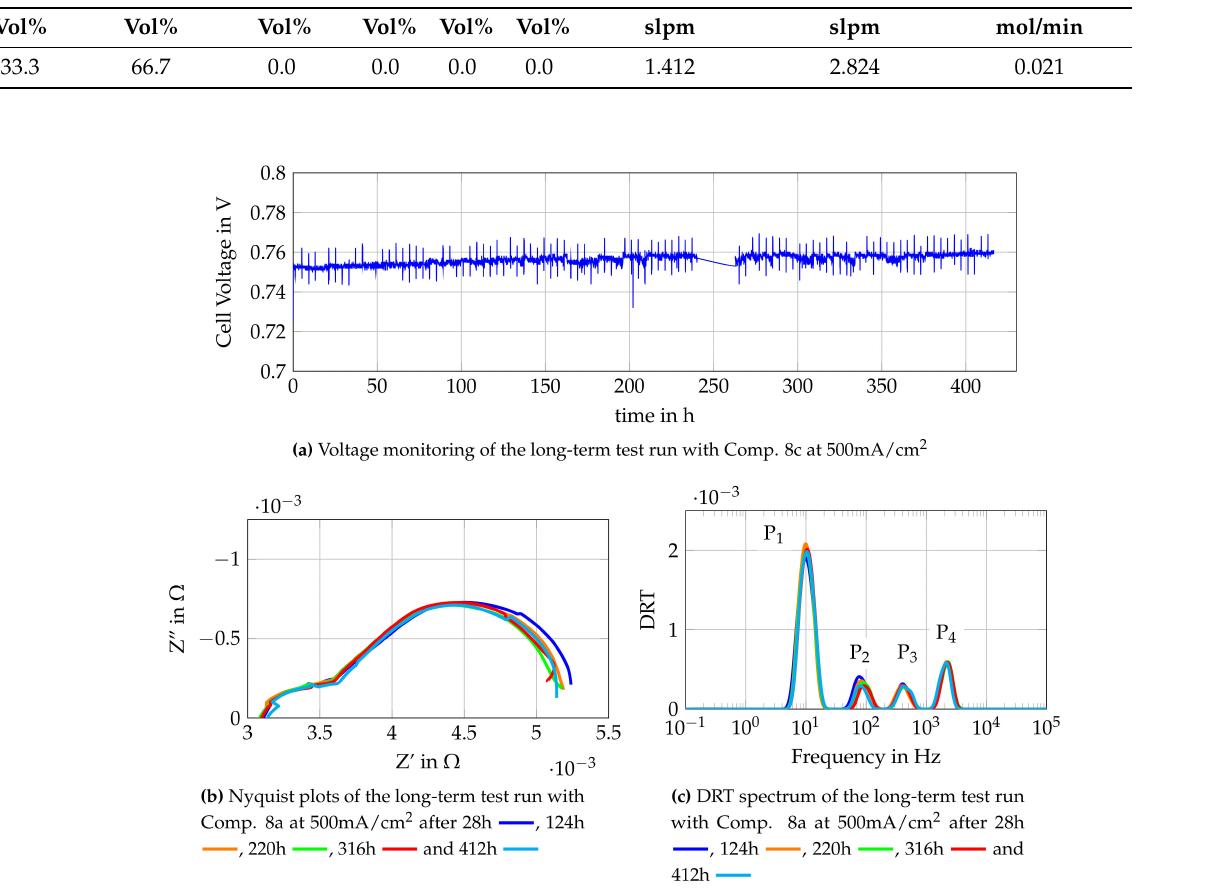
Figure 17. Monitoring data of the single cell fuelled with Comp. 8c at 500 mA/cm 2